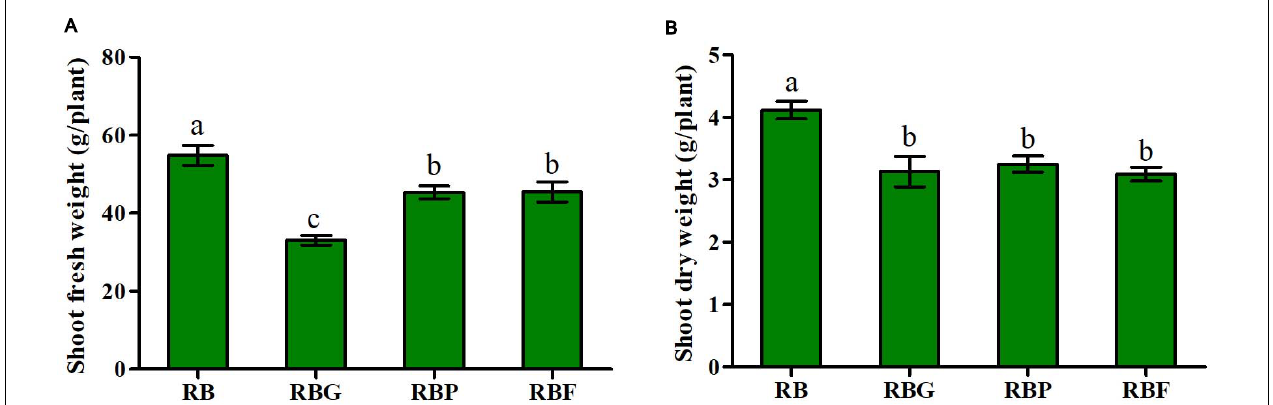
FIGURE 2 | Effects of spectra on shoot fresh weight (A) and dry weight (B) in lettuce. RB, 75% red + 25% blue LED; RBG, 60% red + 20% blue + 20% green LED; RBP, 60% red + 20% blue + 20% purple LED; RBF, 60% red + 20% blue + 20% infrared LED. The letters represent the significant difference of different treatments ( p < 0.05).